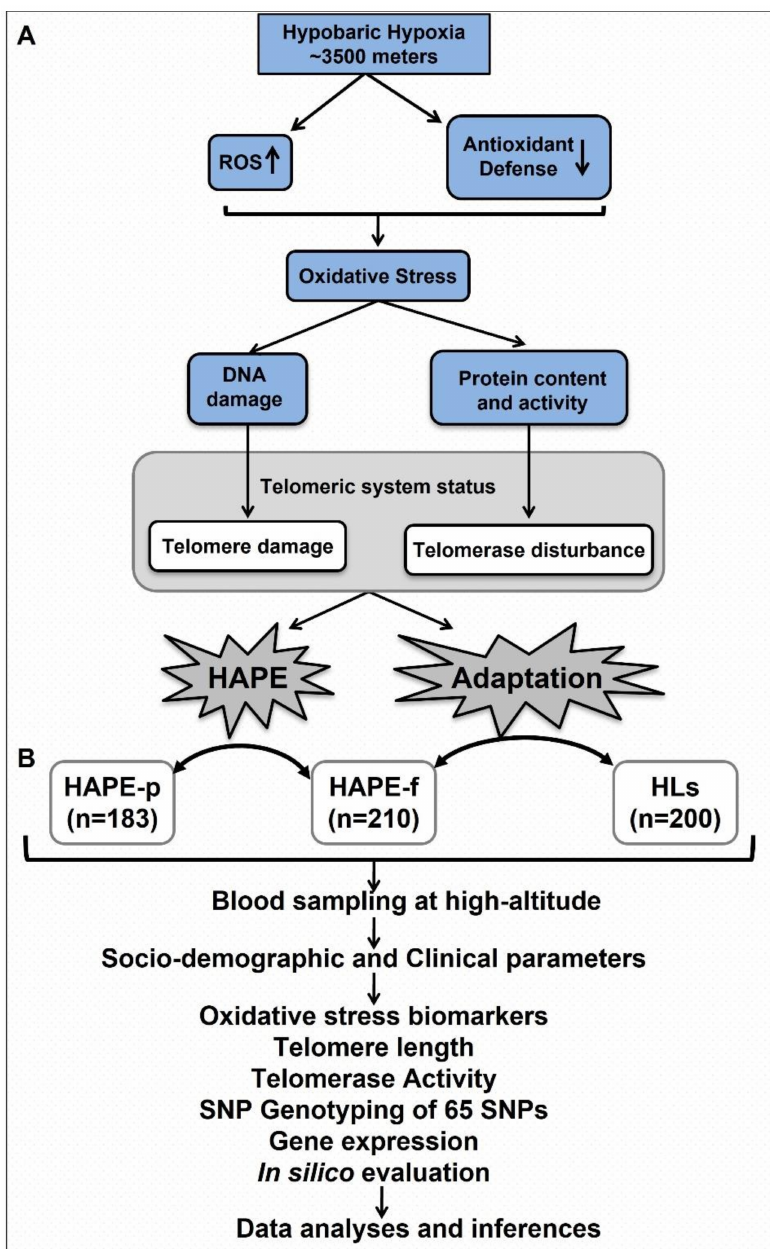
Figure 1. Schematic presentation of the study. ( A ) Hypothesis of the study. The telomere-telomerase system is influenced by oxidative stress under the hypobaric hypoxic environment of high-altitude. In a sequential process, they play a crucial role in HAPE pathophysiology and HA adaptation. ( B ) Study design. Study subjects were recruited, and their sampling was conducted at high-altitude (~3500 m above sea level). Socio-demographic and clinical data were collected at the time of recruitment. Plasma biomarkers namely, 8-isoPGF2 α and total antioxidants, telomere length and telomerase activity were estimated, followed by SNP genotyping, gene expression and in silico analyses to evaluate the site-specific protein structure variations. All the data were analyzed using relevant statistical and bioinformatic tools and are described in the Methods section. ROS, reactive oxygen species; HAPE, high-altitude pulmonary edema; HAPE-p, HAPE patients; HAPE-f, HAPE-free healthy controls; HLs, high-land natives; SNPs, single nucleotide